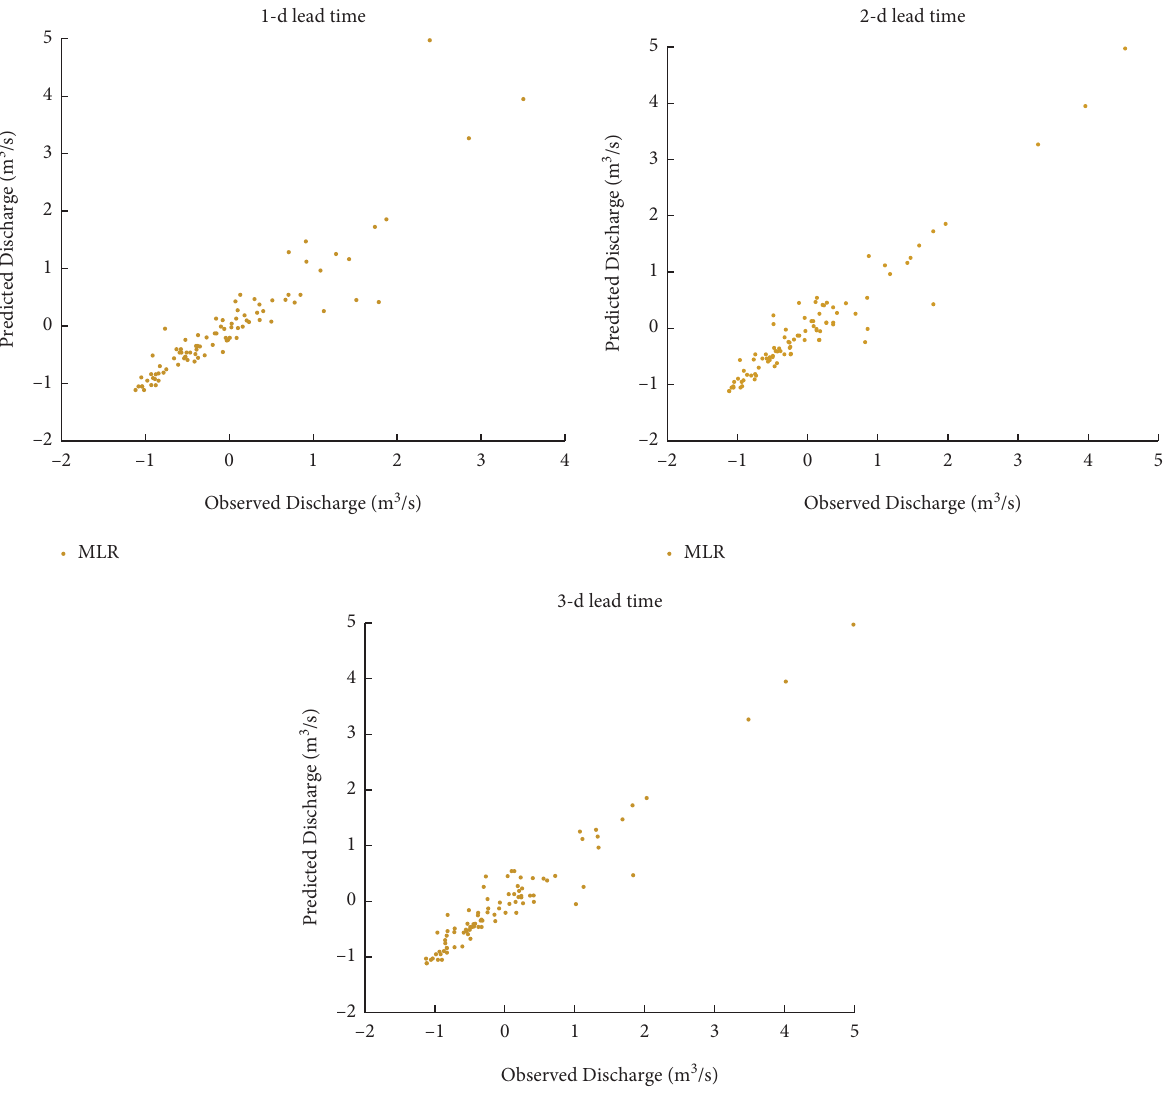
Figure 5: Scatter diagram represents the observed discharge on the horizontal axis means the data recorded on the Qad gauging station (represented by Y in the model). On the vertical coordinate, predicted discharge means the data obtained after ftting the MLR